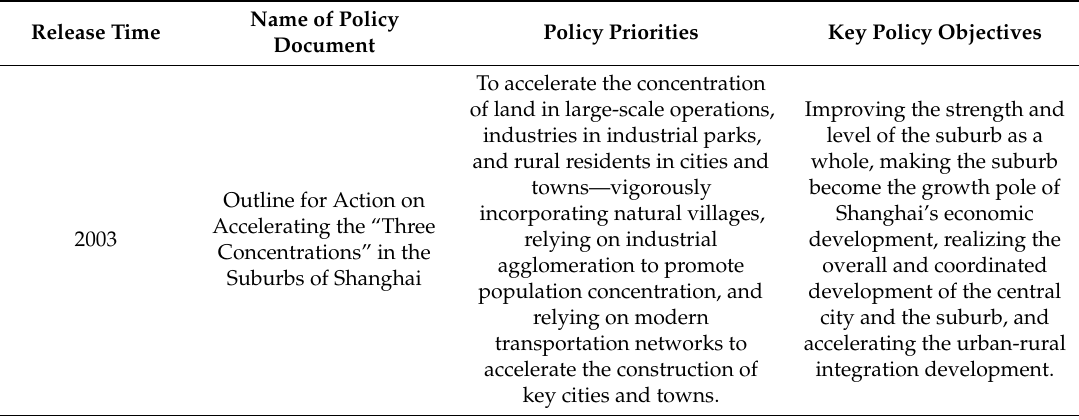
Table 1. The main policy documents for promoting rural residential concentration in the suburbs of Shanghai since